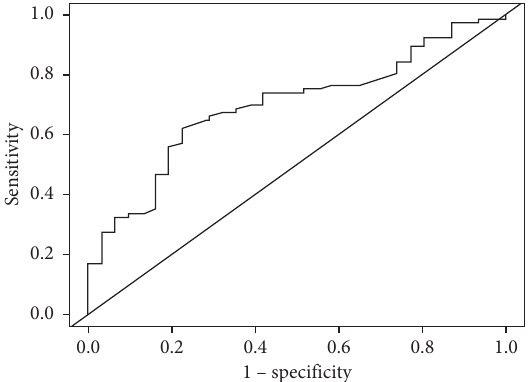
Figure 3: Receiver-operating characteristic curve of predicting the microvascular obstruction phenomenon after primary percuta- neous intervention of nondiabetic ST-segment elevation myocar- dial infarction